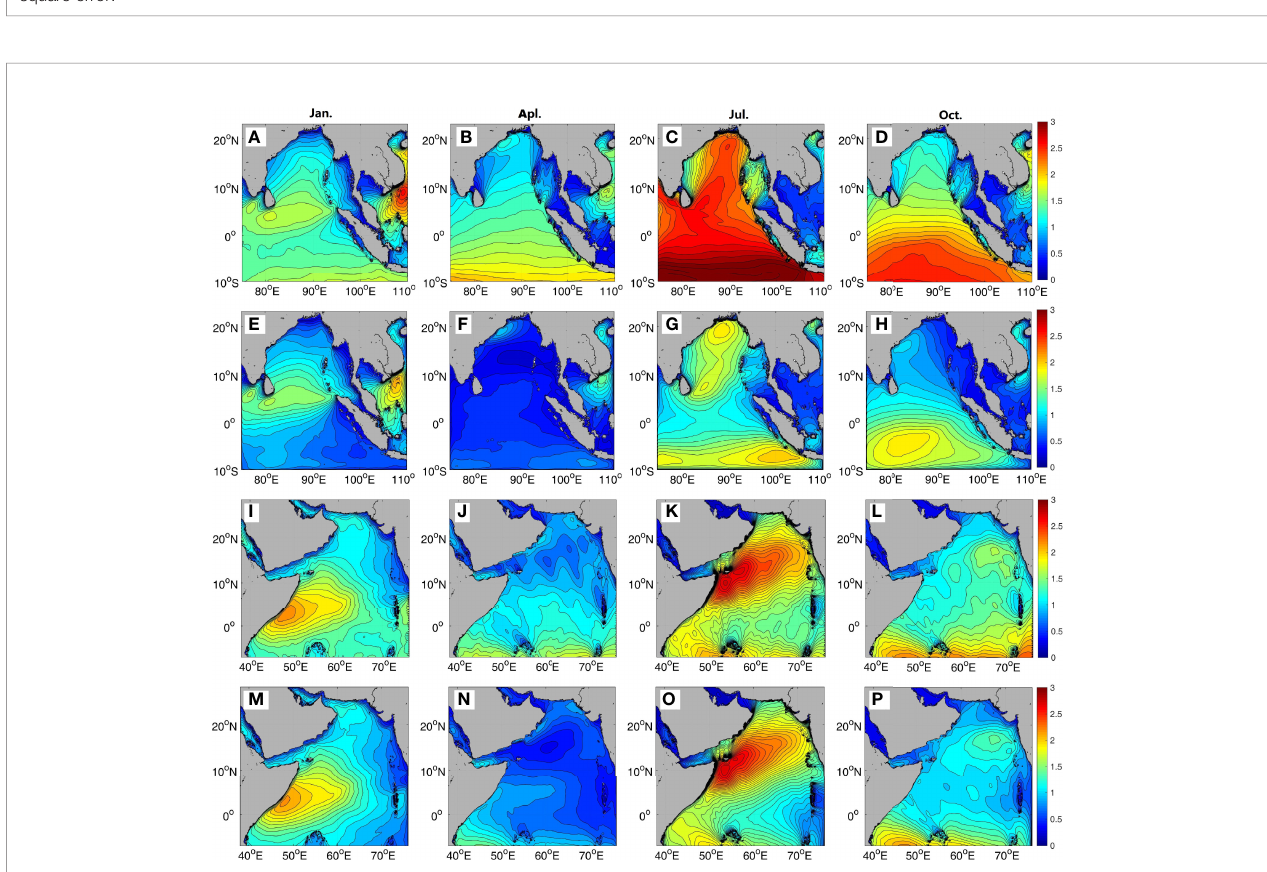
FIGURE 12 | The mean signi fi cant wave height (SWH, unit: m) of the (A – H) EIO and (I – P) WIO in (A, E, I, M) January, (B, F, J, N) April, (C, G, K, O) July, and (D, H, L, P) October from (A – D, I – L) CTRL and (E – H, M – P)